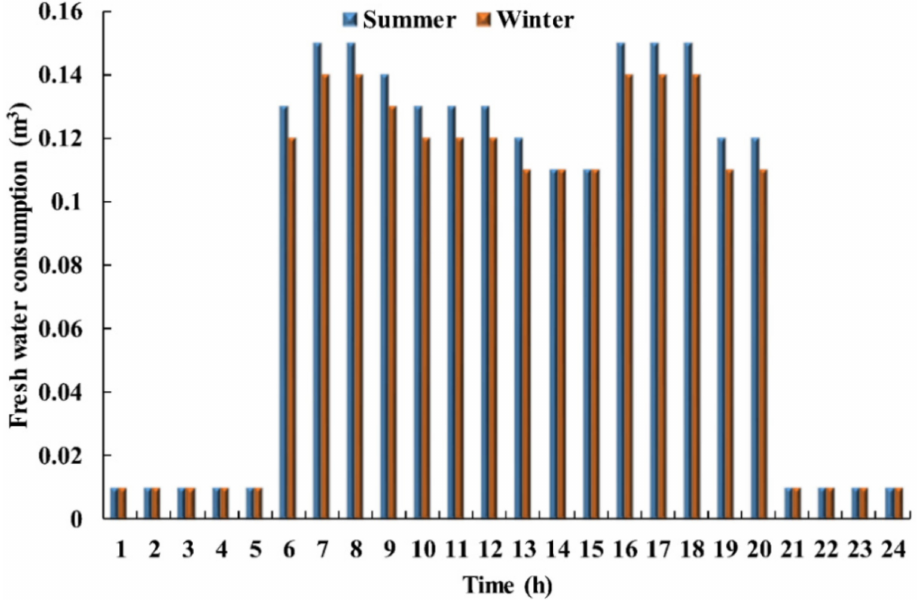
Figure 4. The volumetric hourly freshwater demand for both the winter and summer